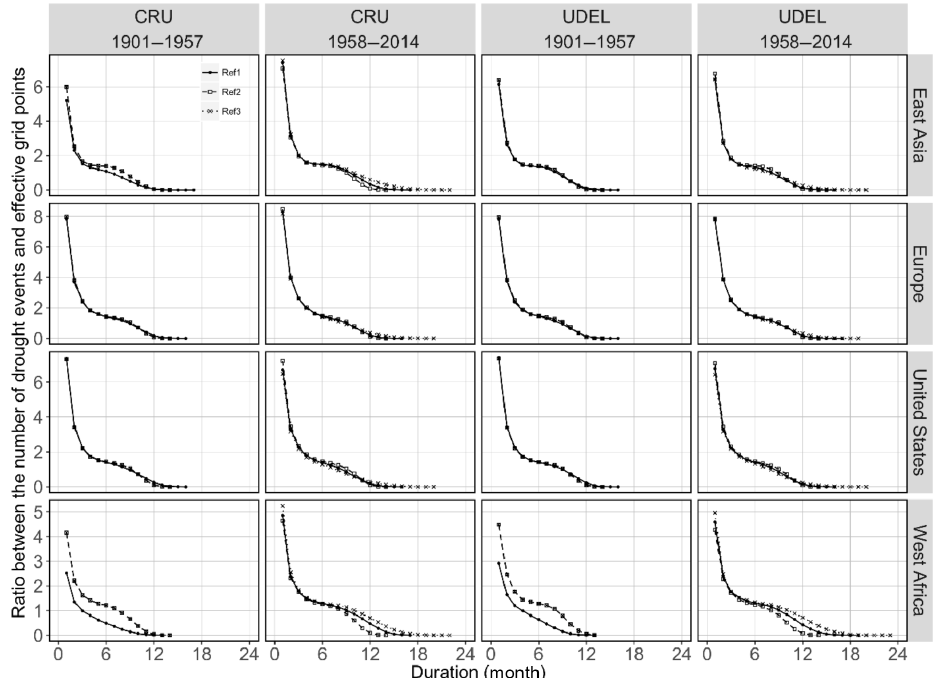
Figure 9. Ratios between the number of drought events and the number of terrestrial data grid points in three different reference periods (Ref1, Ref2 and Ref3 in Table 2) based on the CRU and UDEL datasets from 1901 to 1957 and 1958–2014 in each region.